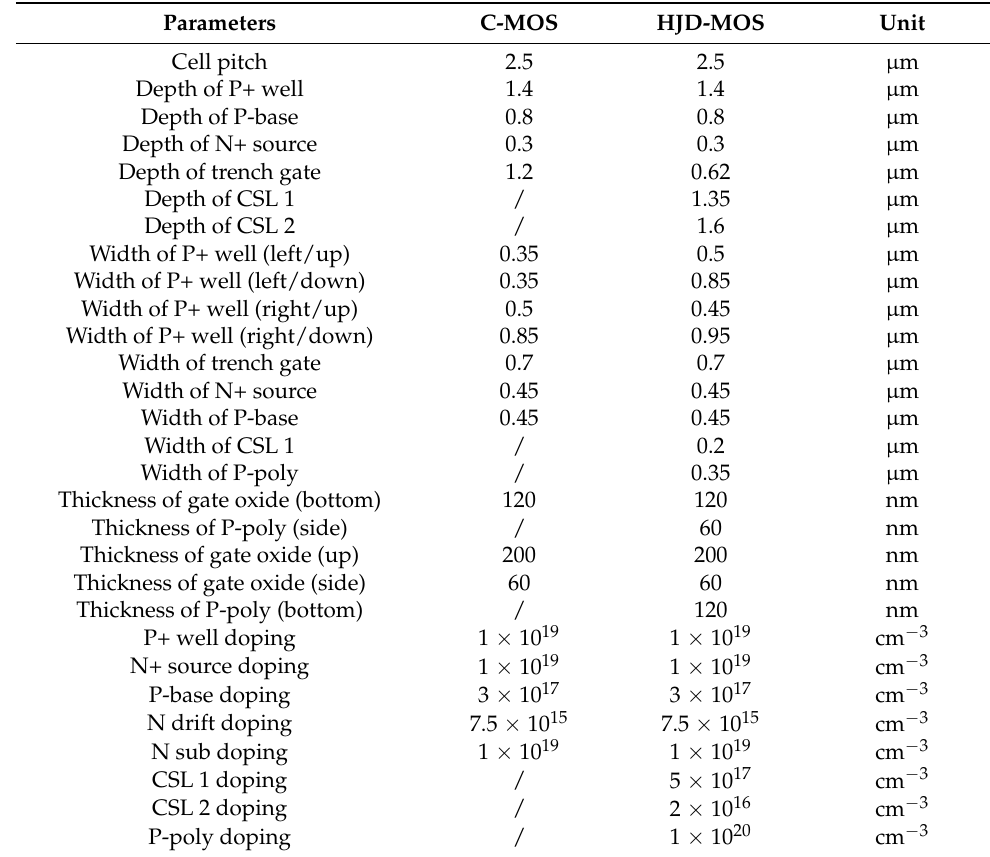
Table 1. Parameters of C-MOS and Proposed